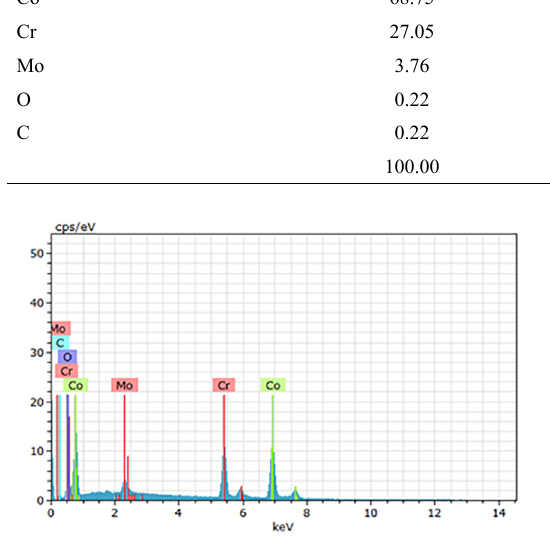
Figure 1. EDS spectra of Co-Cr-Mo for chemical composition evaluation